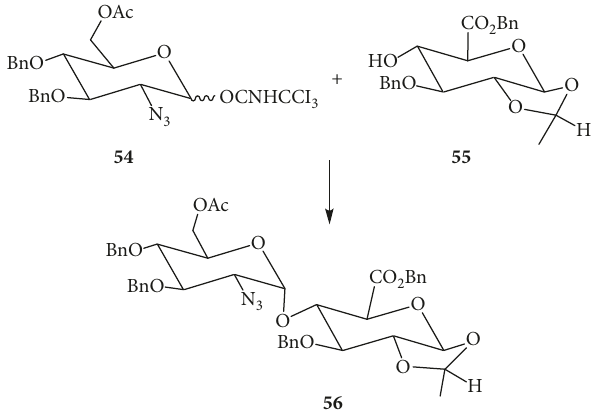
Scheme 17: Reliable’s strategy for the synthesis of the ED